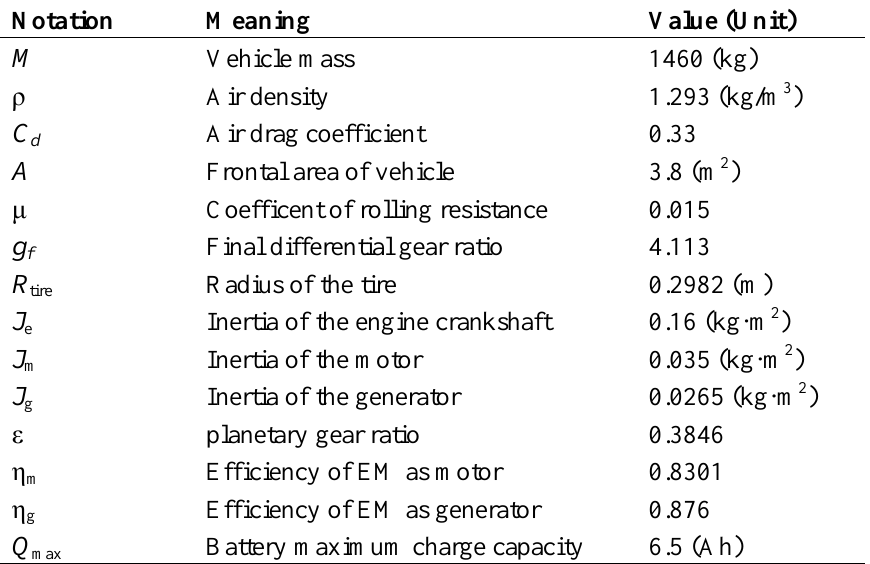
Table 1. Basic parameters of the HEV powertrain used in